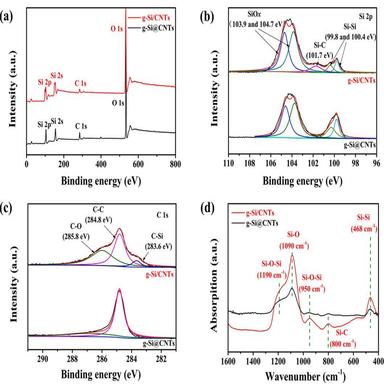
(a) XPS survey spectrum of the g-Si/CNTs composite; (b) Si 2p and (c) C 1s spectra of g-Si/CNTs and g-Si@CNTs composite; (d) FTIR spectra of g-Si/CNTs and g-Si@CNTs composite.